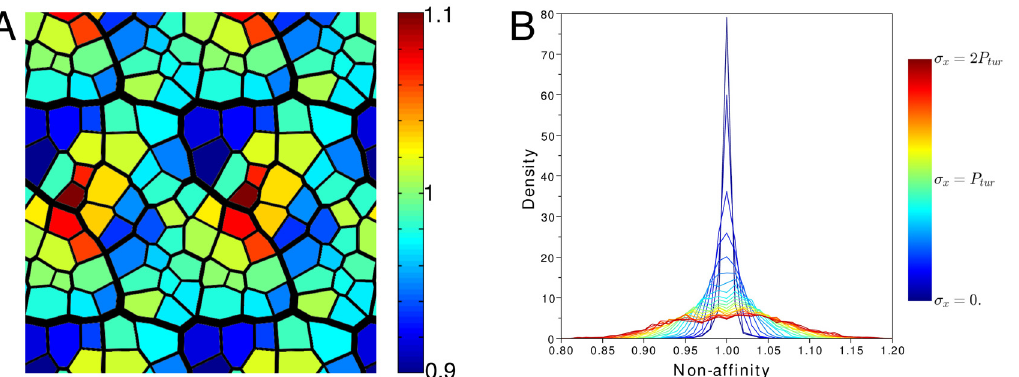
Fig 3. Veins in numerical simulations undergo non-affine deformations. (A) Colormap of the non-affinity index q of each areole, for one realization of the numerical simulation with stretching in the y − direction ( σ yy = P tur as in Fig 2); in the case of an affine dilation q would be equal to one for all areoles; q > 1 (resp. q < 1) means that the areole grew more (resp. less) than its neighbourhood. (B) Histogram of q over all realizations with stretching in the x − direction and for a stress σ xx ranging from 0 to 2 P tur . As in Fig 2, the simulations were stopped when the leaves doubled their